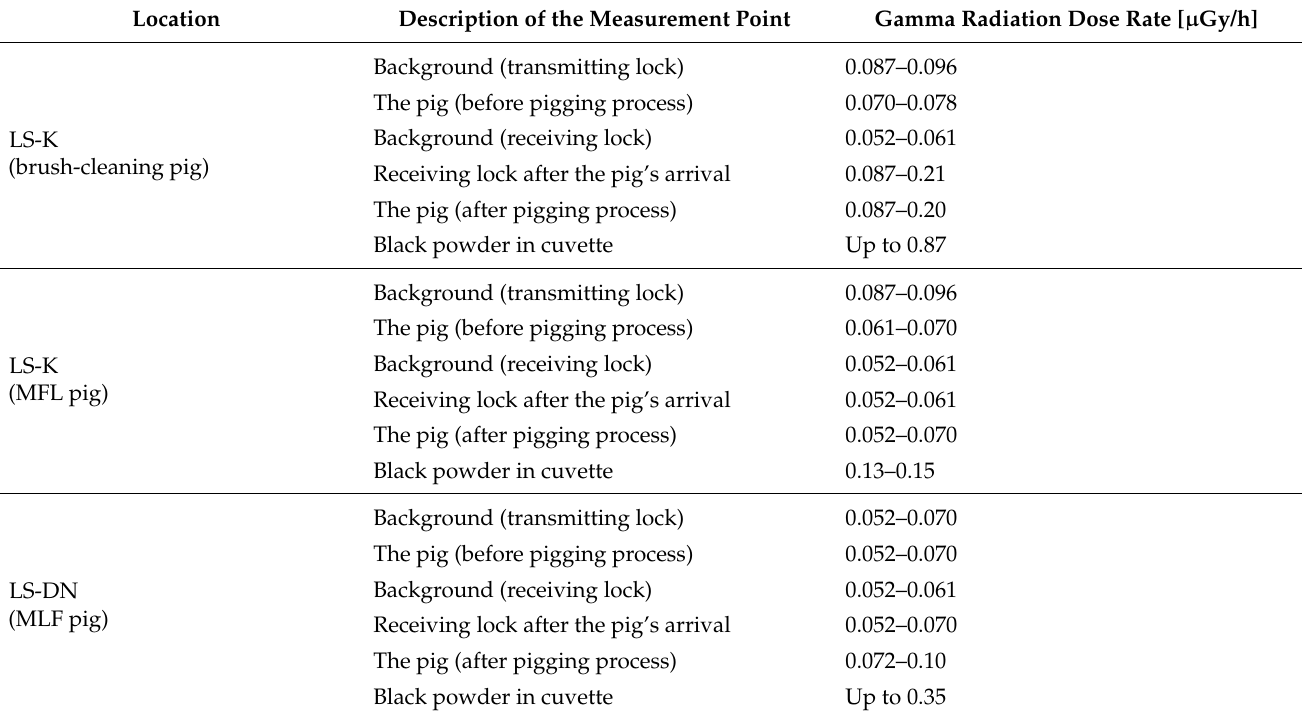
Table 4. Gamma radiation dose rate during the maintenance process of gas pipeline (the